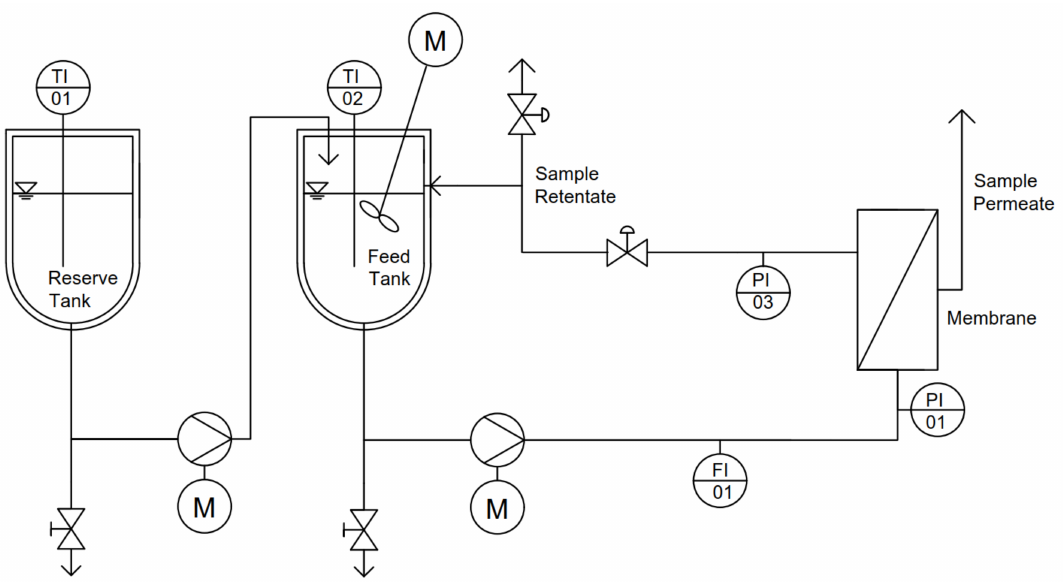
Figure 1. Piping and instrumentation scheme of the filtration plant (TI: temperature indicator; FI: flow indicator; PI: pressure indicator; M: